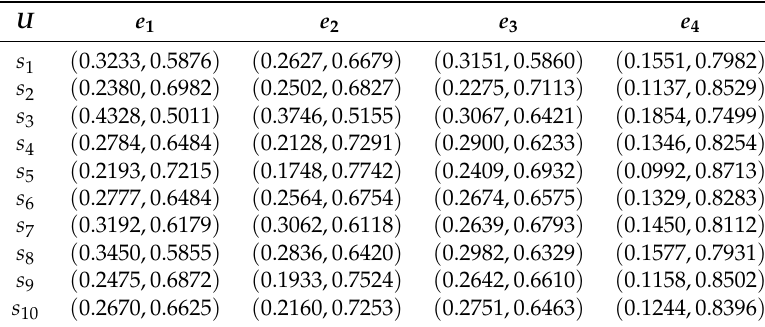
Table 7. Weighted IFSS R = µ (cid:74) G = ( (cid:101) R , C )